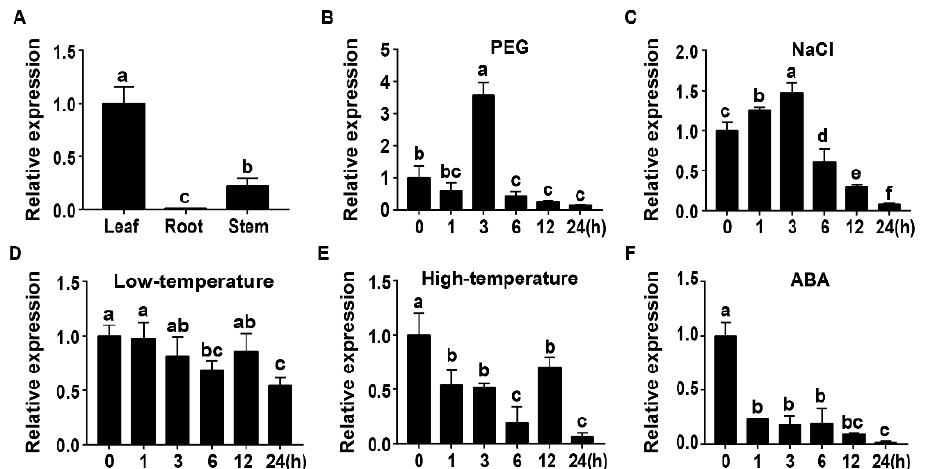
Figure 2. Transcription profiles of TaWRKY46 . ( A ) Organ expression assay of TaWRKY46 in different wheat organs (leaf, root, and stem). Transcription profiles of TaWRKY46 under 20% PEG 6000 ( B ); 200 mM NaCl ( C ); 4 C° ( D ); 42 C° ( E ); 100 μM ABA ( F ) treatments in wheat leaves. The transcriptional level at time point 0 (for the multiple stress experiments) and the leaf (for the organ expression assay) was defined as 1.0.